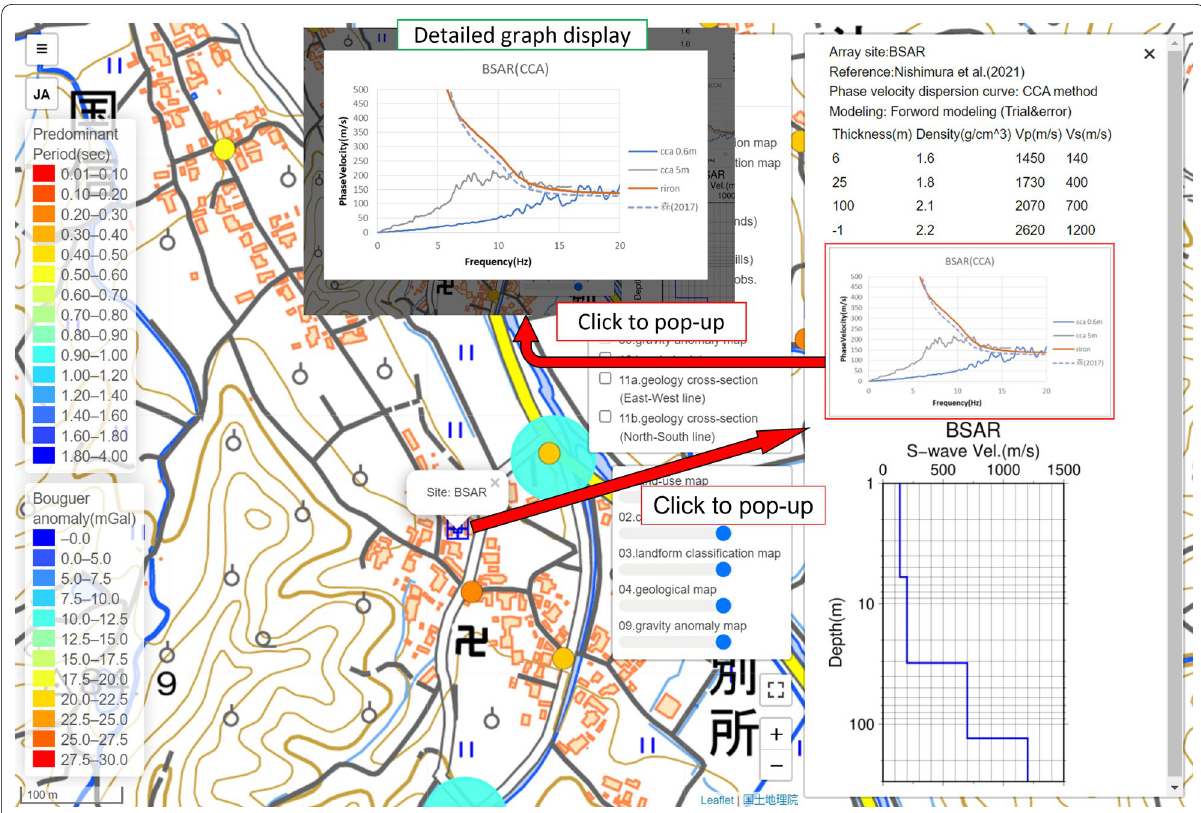
Fig. 5 This figure shows an example window of detailed information for array observations. The right window of the array observation map shows the subsurface model, the phase velocity dispersion curve, and a graph of the S-wave velocity